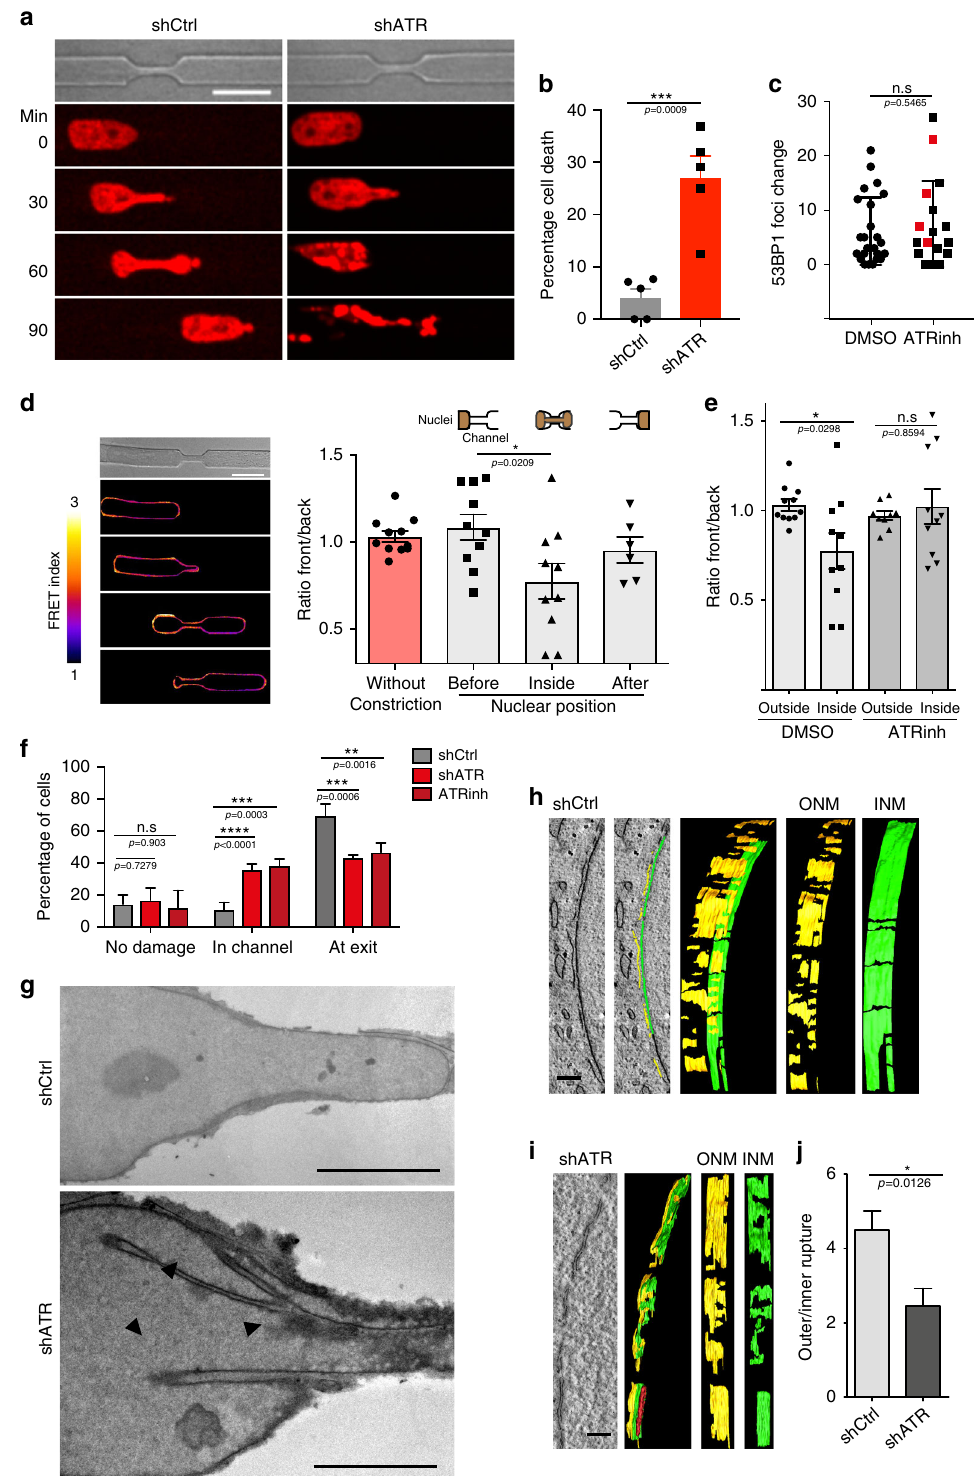
Fig. 3f – i). Control cells approached the constrictions by deforming their nuclei at the leading edge without aberrant NE structures (Fig. 4g and Supplementary Fig. 3f) or, occasionally, with well- organized NE invaginations parallel to the direction of migration (Supplementary Fig. 3g). Conversely, most of ATR-depleted nuclei were deformed, exhibiting several NE invaginations in the